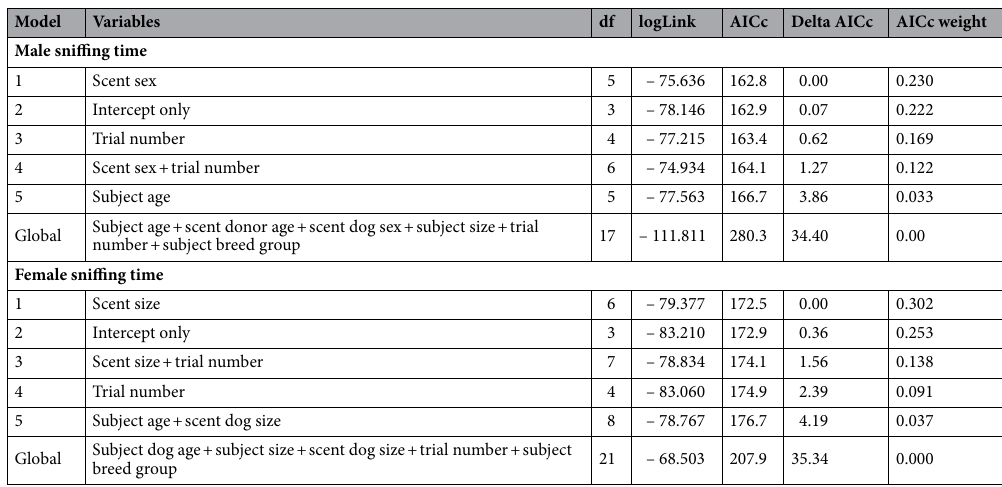
Table 2. The most parsimonious models (based on AIC weights) and the full model for the sniffing duration for male and female dogs smelling conspecific pedal scent from a male and female scent donor as well as a control over three random